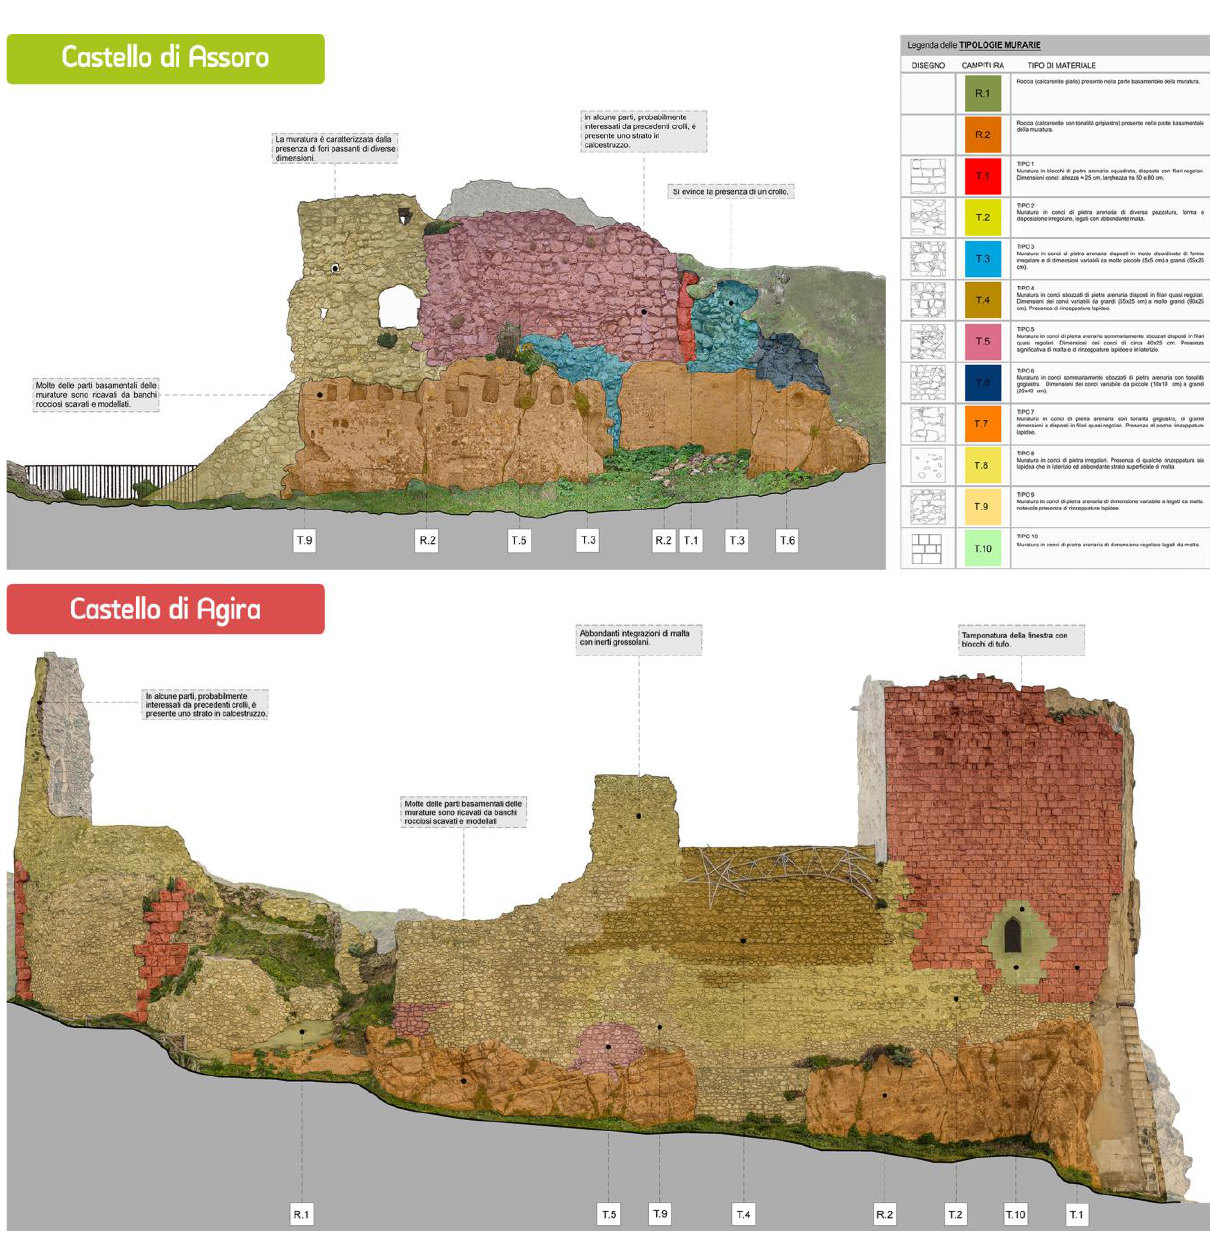
Figure 5. Characterization of masonry typologies in the castles of Assoro (above) and Agira